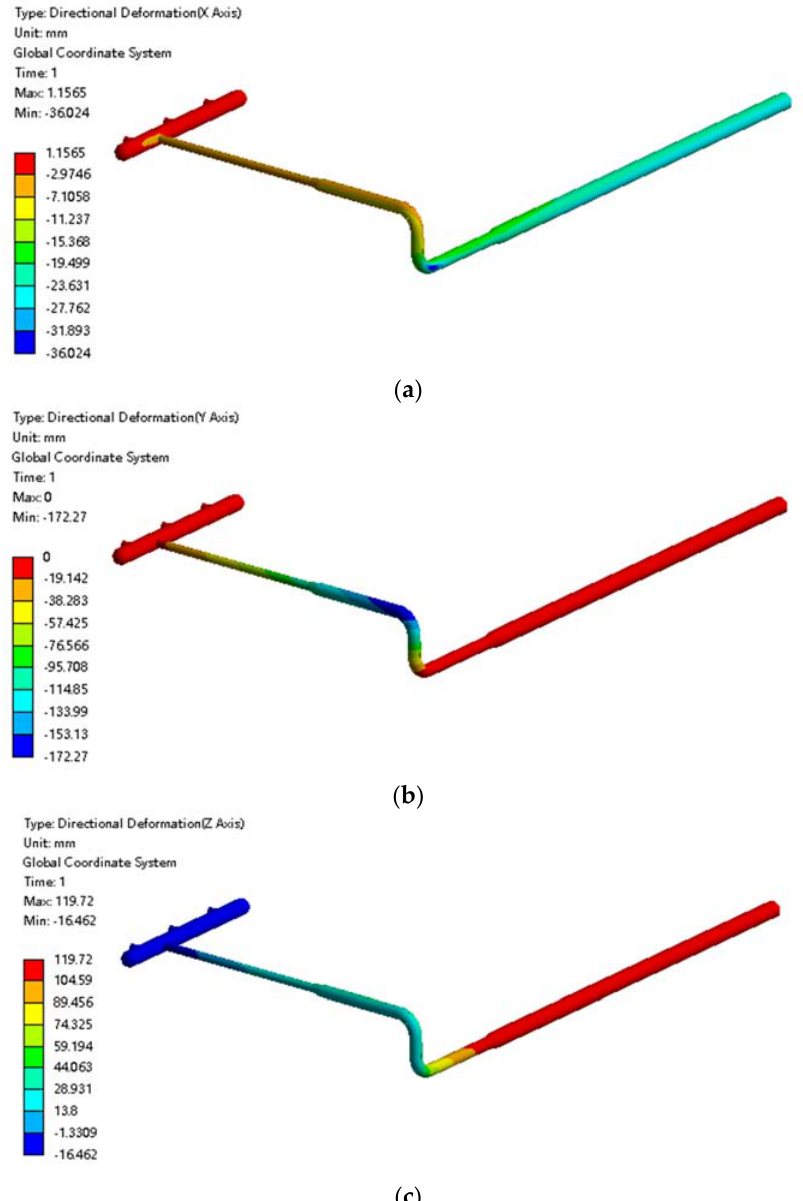
Figure 8. Cloud diagram of the pipeline displacement under frost heave: ( a ) Displacement cloud diagram of the pipeline in the x direction; ( b ) displacement cloud diagram of the pipeline in the y direction; ( c ) displacement cloud diagram of the pipeline in the z direction.